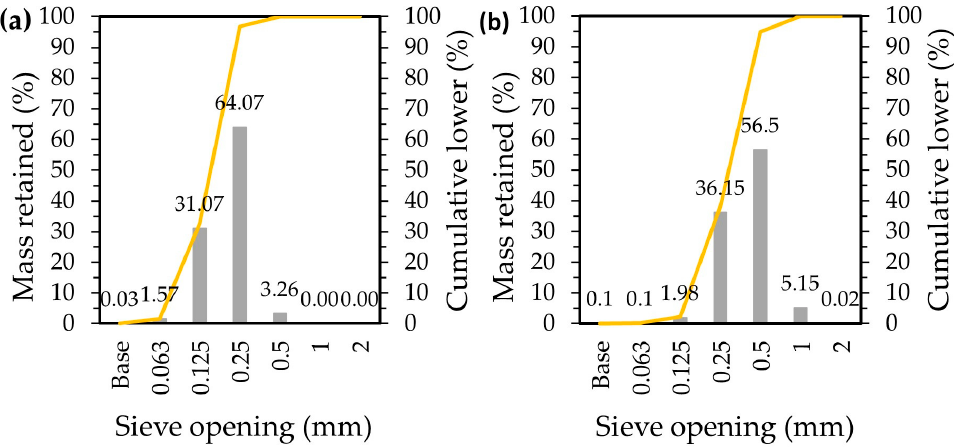
Figure 9. Particle size distribution of the two natural siliceous sands used: ( a ) S1; ( b ) S2. The slaker grits (SG) and the two types of biomass fly ash (BFA) used, BFA1 and BFA2, were provided by a Portuguese pulp and paper producer. BFA1 and BFA2 were generated in a biomass power plant and in a cogeneration plant, respectively, both equipped with